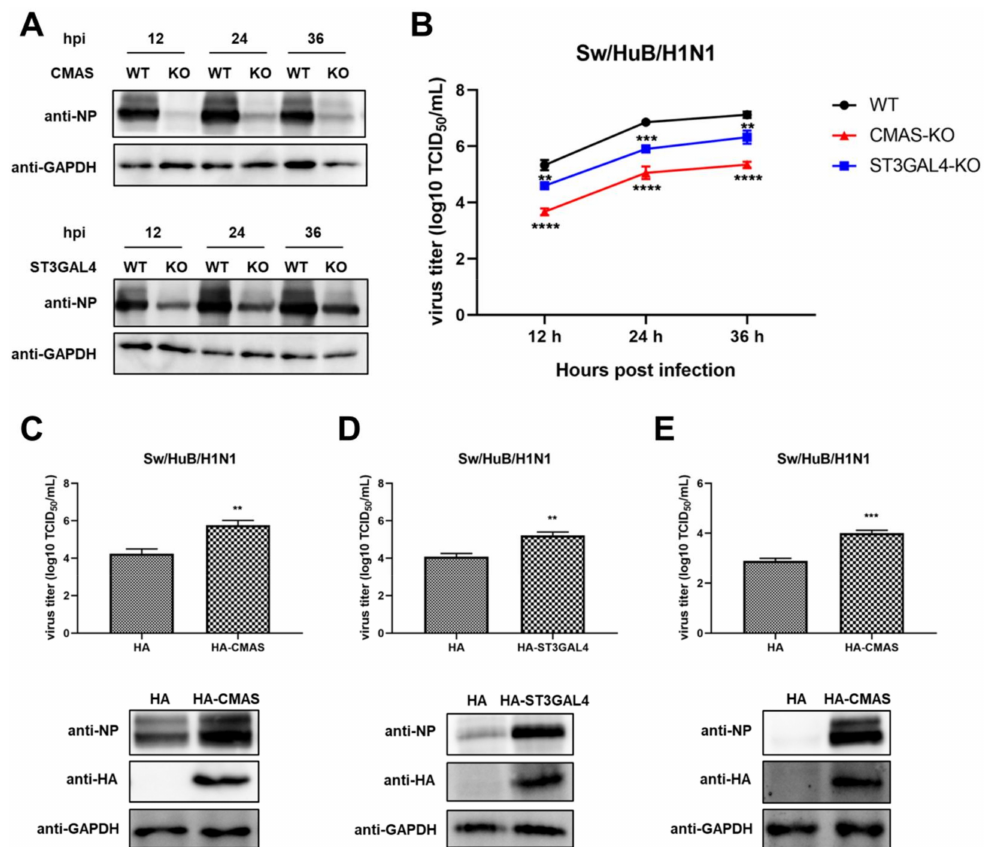
Figure 3. Knockout of CMAS or ST3GAL4 negatively modulates the proliferation of the swine influenza virus. CMAS -KO and ST3GAL4 -KO NPTr cells were generated through the CRISPR/Cas9 system. NPTR-Cas9 cells were used as wild-type control. ( A , B ) Effects of KO cell lines on the proliferation of swine influenza viruses. WT NPTr cells and KO NPTr cells were infected with Sw/HuB/H1N1 virus (MOI = 0.01); cell supernatants and lysates were collected at 12, 24 and 36 hpi. ( A ) Viral protein expressions were detected by Western blotting or ( B ) virus titers were determined by TCID 50 assay on MDCK cells. (Data from three independent experiments, mean ± SD; ** p < 0.01; *** p < 0.001; **** p < 0.0001; one-way ANOVA.) ( C , D ) pCAGGS-HA (HA), HA- CMAS or HA- ST3GAL4 plasmid was transfected into WT NPTr cells, and inoculated with a Sw/HuB/H1N1 virus 24 h later (MOI = 0.01); then, cell supernatants and lysates were collected at 24 hpi and virus titers were determined by TCID 50 assay on MDCK cells or viral proteins expression were detected by Western blotting. ( E ) pCAGGS-HA (HA) or HA- CMAS plasmid was transfected into CMAS -KO NPTr cells, and inoculated with a Sw/HuB/H1N1 virus 24 h later (MOI = 0.01); then, cell supernatants and lysates were collected at 24 hpi and virus titers were determined by TCID 50 assay on MDCK cells or viral proteins expression were detected by Western blotting. (Data from three independent experiments, mean ± SD; ** p < 0.01; *** p < 0.001; two-tailed Student’s t